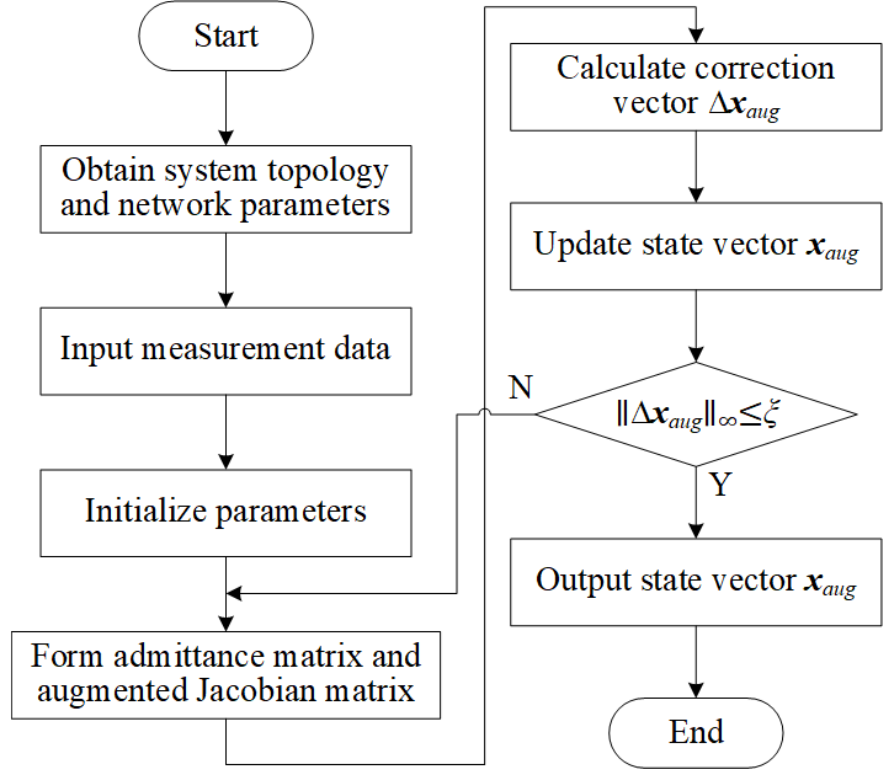
Figure 2. Flowchart of the proposed AJ-ETC-ES approach.